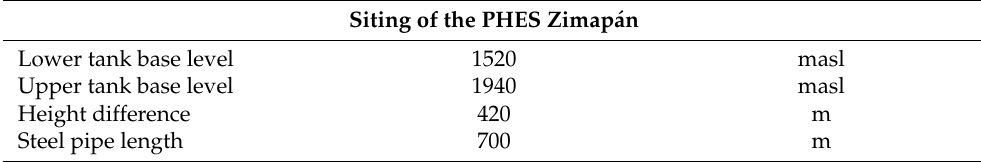
Table 2. Siting of the PHES Zimapán.